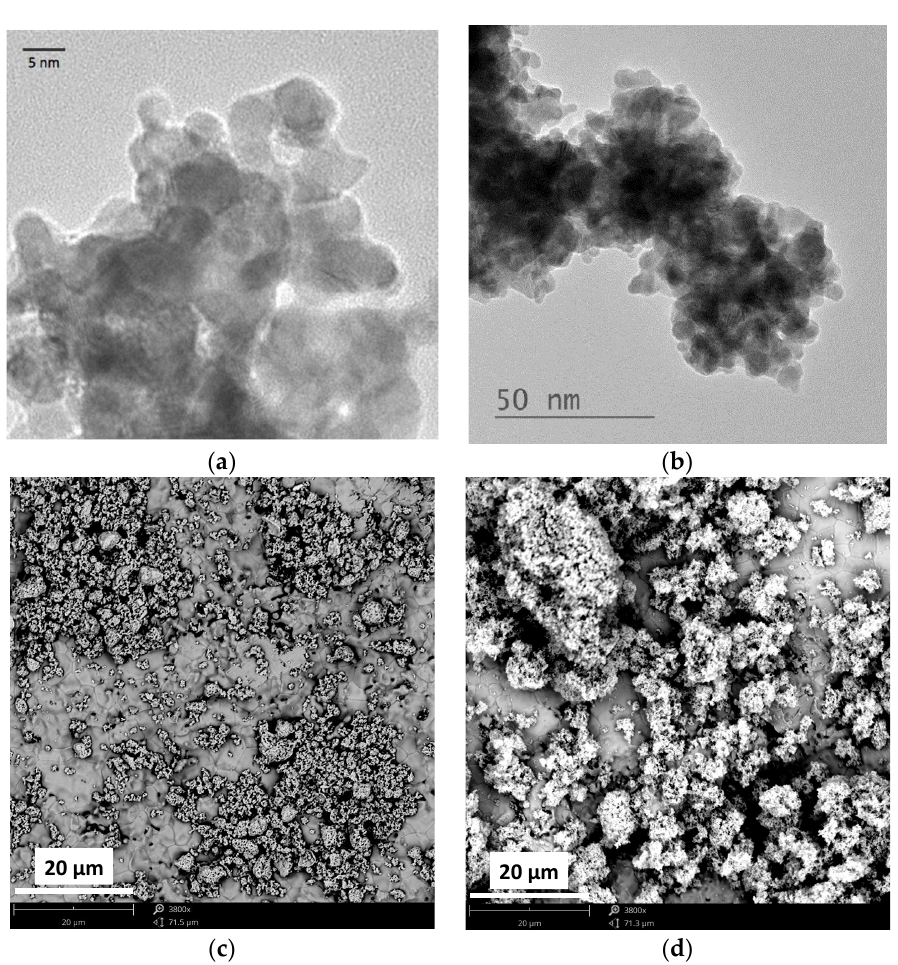
Figure 1. ( a , b ) TEM images of stand-alone Pd NPs at 5 nm and 50 nm scale; ( c , d ) SEM images of as-prepared ( c ) and post-experiment ( d ) Pd catalyst deposited on YSZ solid electrolyte.